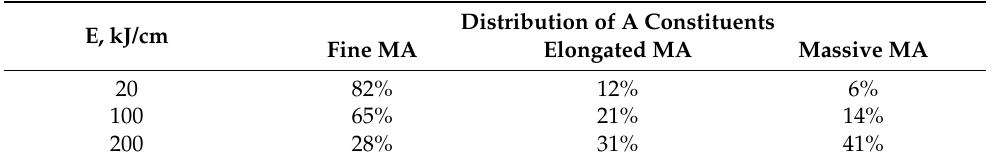
Figure 4. Histogram of MA distribution in the CGHAZ containing 0.14% Nb. Table 4. Distribution of fine, elongated and massive MA constituents in the CGHAZ containing 0.14% Nb.